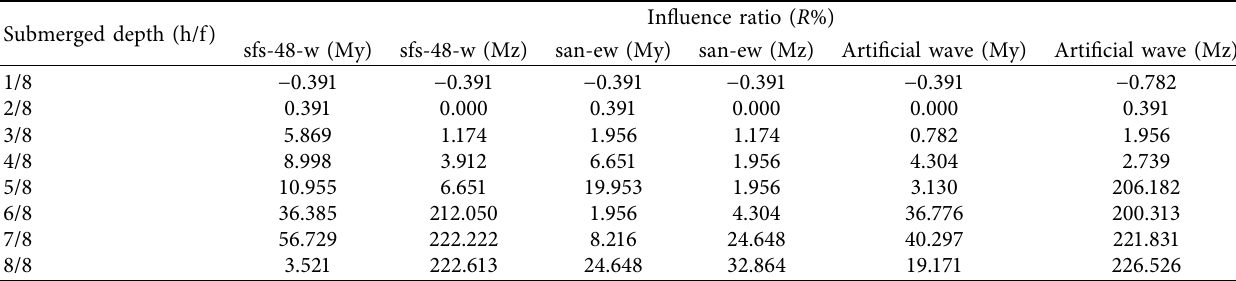
Table 5: Te relation of R and submerged depth at 3L/16 of the arch.